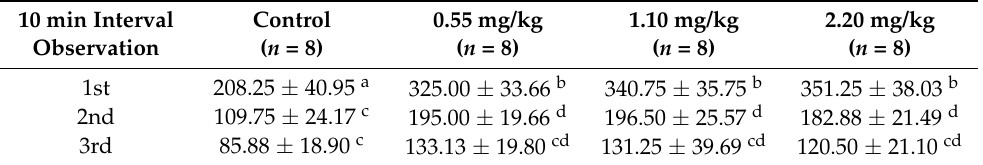
Table 3. Courtship behavior of male rats treated with M. oleifera leaf tea and the control group observed in three 10-min intervals over the 30-min period.